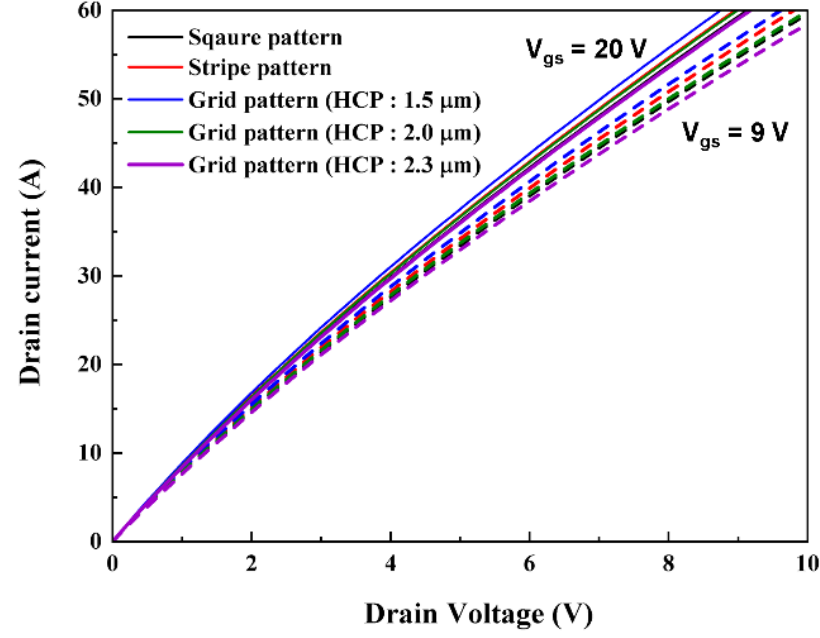
Figure 3. Output characteristics of TMOSFETs with square, stripe, and grid pattern.